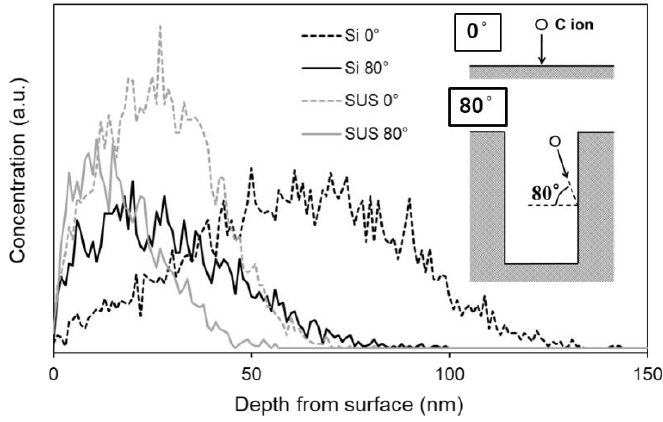
Figure 8. Depth profiles of carbon ion implantation calculated with SRIM.